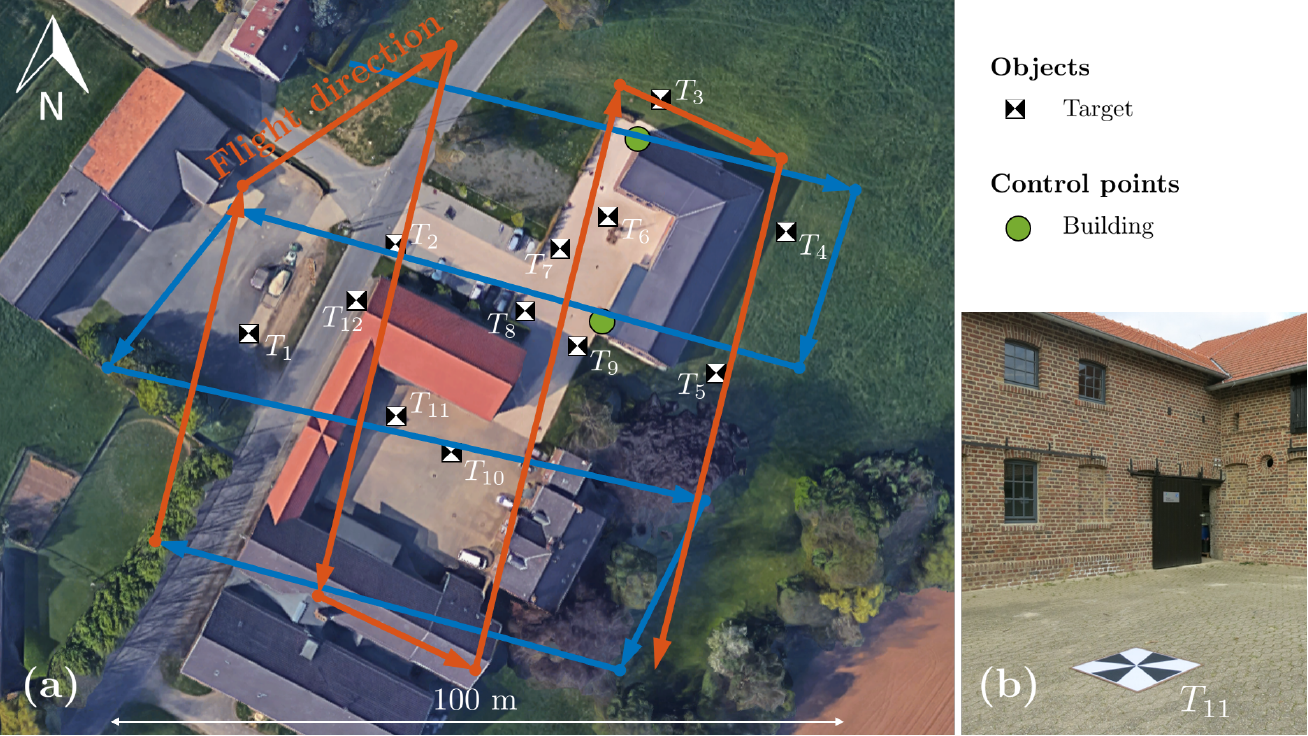
Figure 5. Second study are for the analysis of multiple strip measurement with included objects and the flight pattern of the individual measurement, © https://www.google.de/maps/ (accessed on 14 May